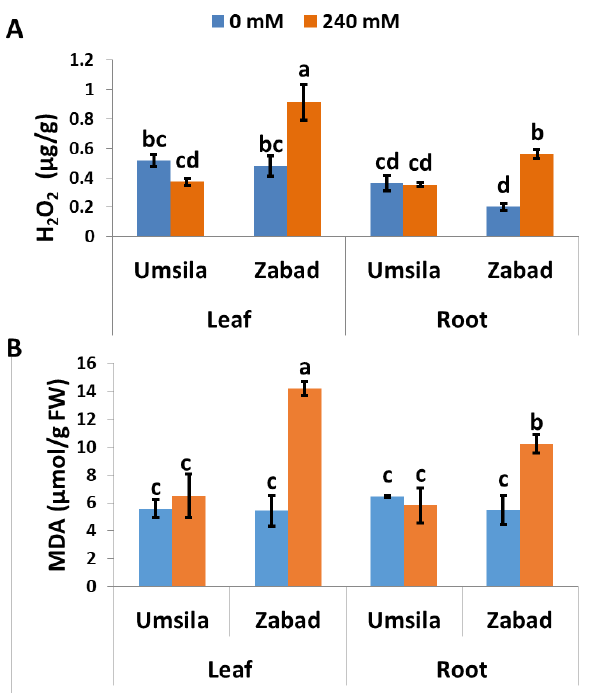
Figure 4. The effect of salinity on the activity of hydrogen peroxidase ( A ) and malondialdehyde ( B ), when date palm seedlings were exposed to control (0 mM NaCl) and high-salinity (240 mM NaCl) conditions. Bars represent the mean ± SE ( n = 3).